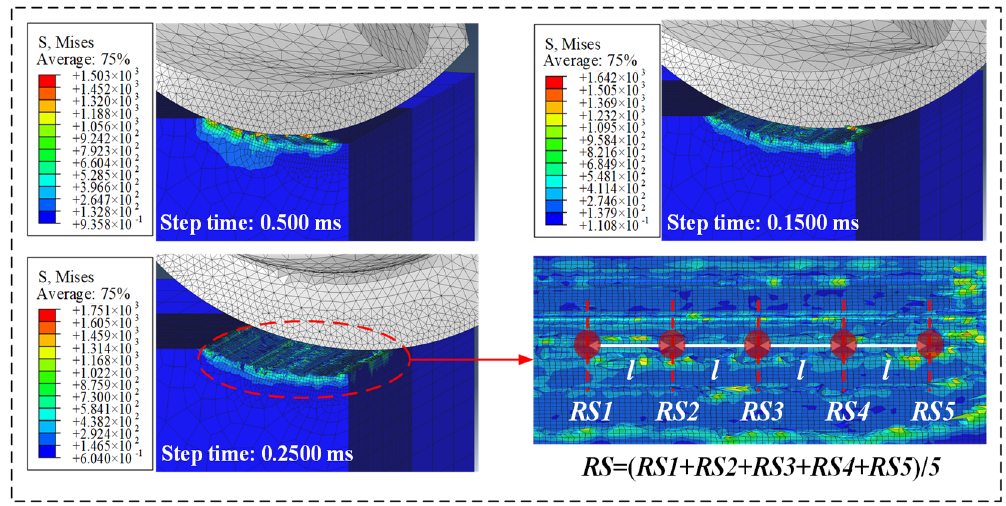
Figure 2. Simulation results and data